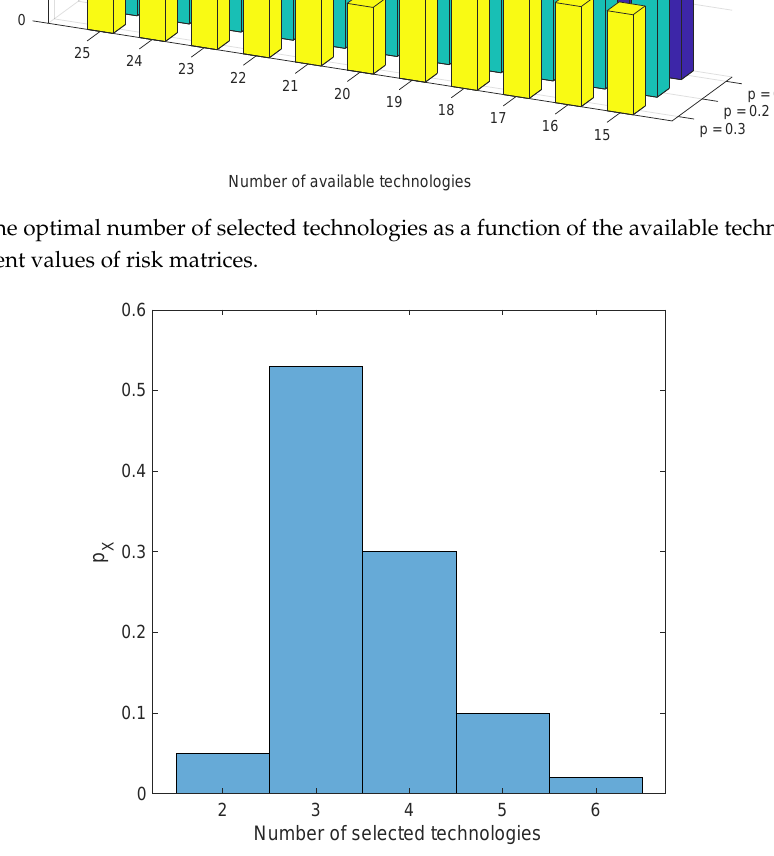
Figure 8. The distribution of the optimal number of selected technologies for 1000 different realizations of the risk matrices. The number of available technologies was set to